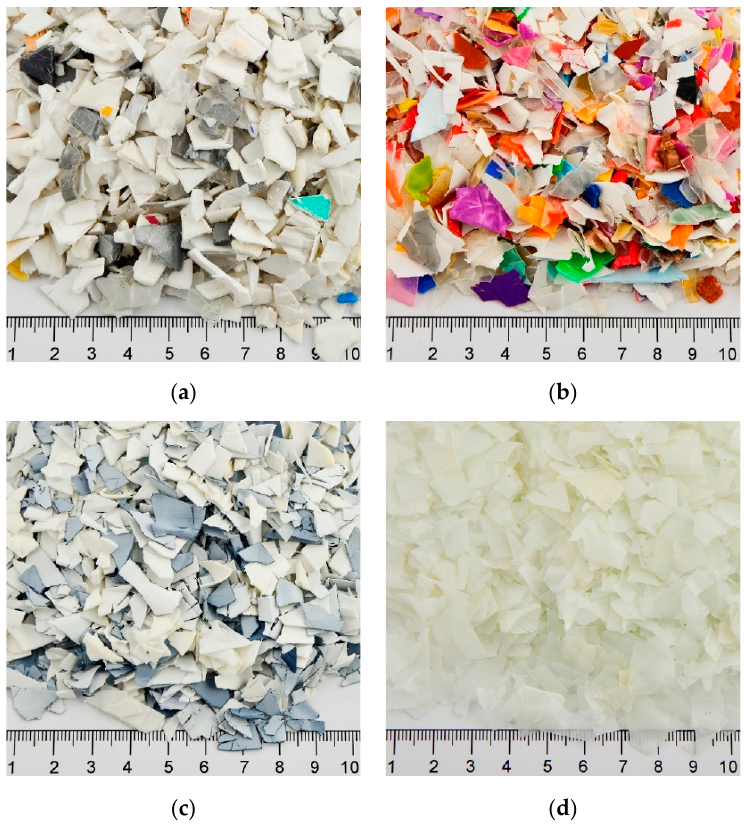
Figure 8. Different pretreated PO waste flakes from postconsumer applications: ( a ) color-sorted rigid PP, ( b ) PP mixture from thin-walled applications, ( c ) PE-HD mixture from multilayer rigid applications, and ( d ) color-sorted PE-HD grade from thin-walled applications.